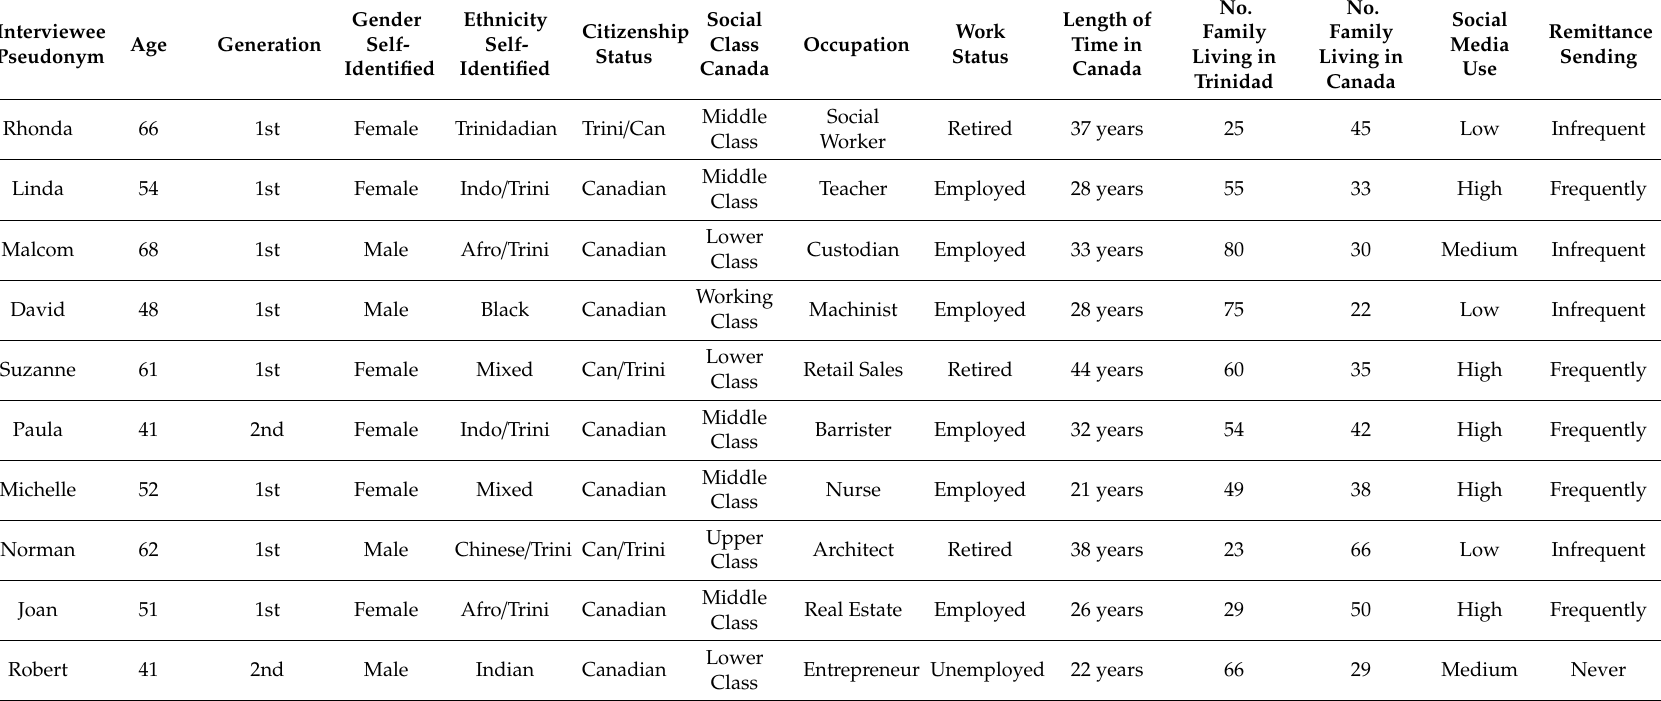
Table 1. Characteristics of interviewees for the Trinidadian transnational caring